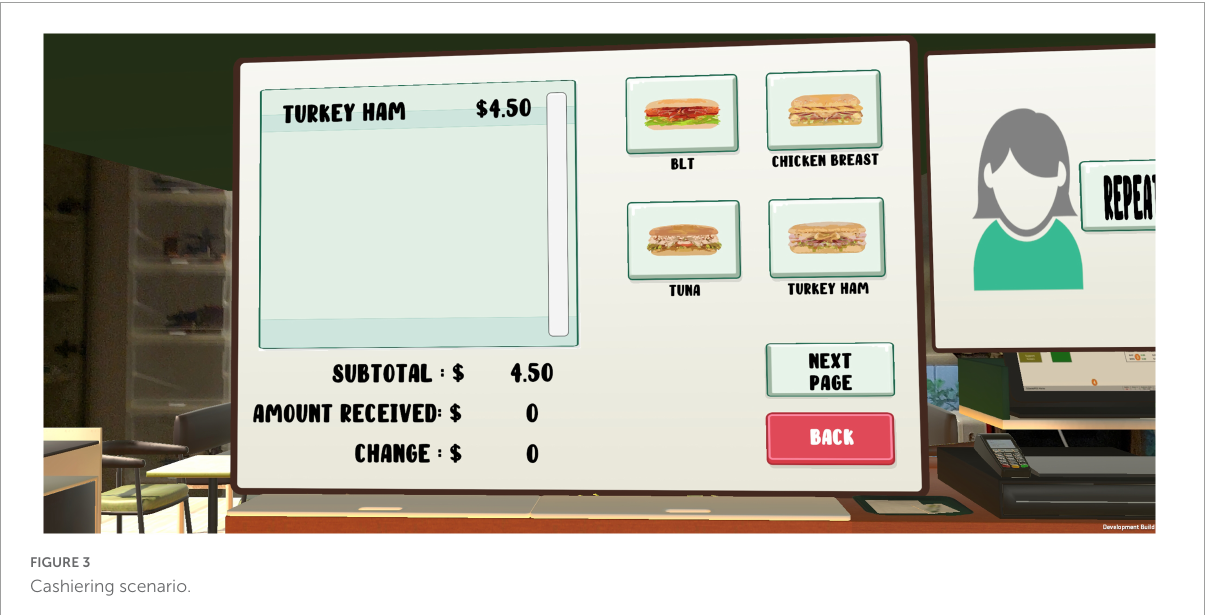
disorders. Cognistat was administered at baseline, post-training and eight-weeks after completion of the